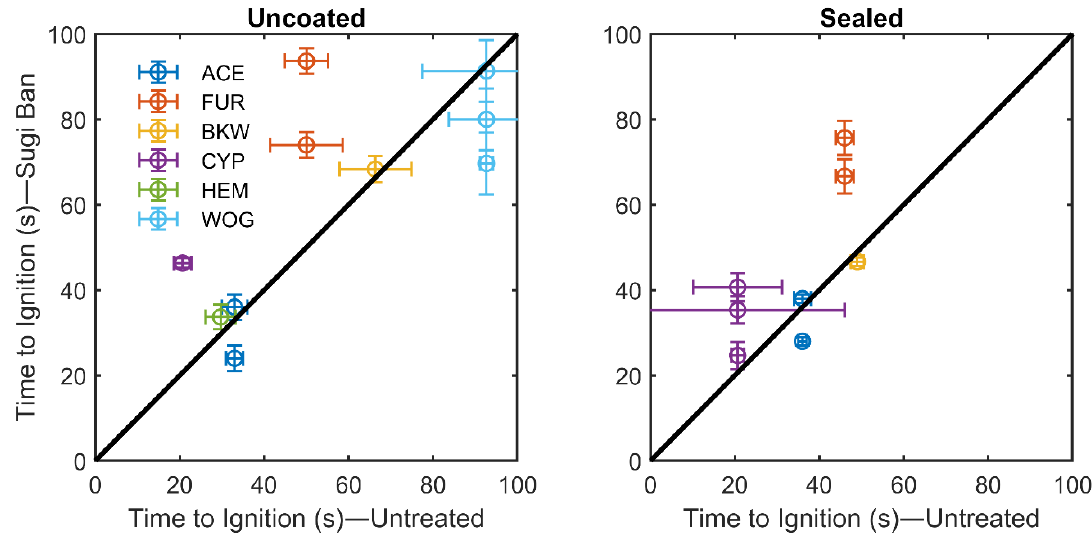
Figure 4. Comparison of the time to ignition (T ig , s) between the untreated and charred wood specimens for both the uncoated and sealed specimens. The error bars represent the standard deviation.